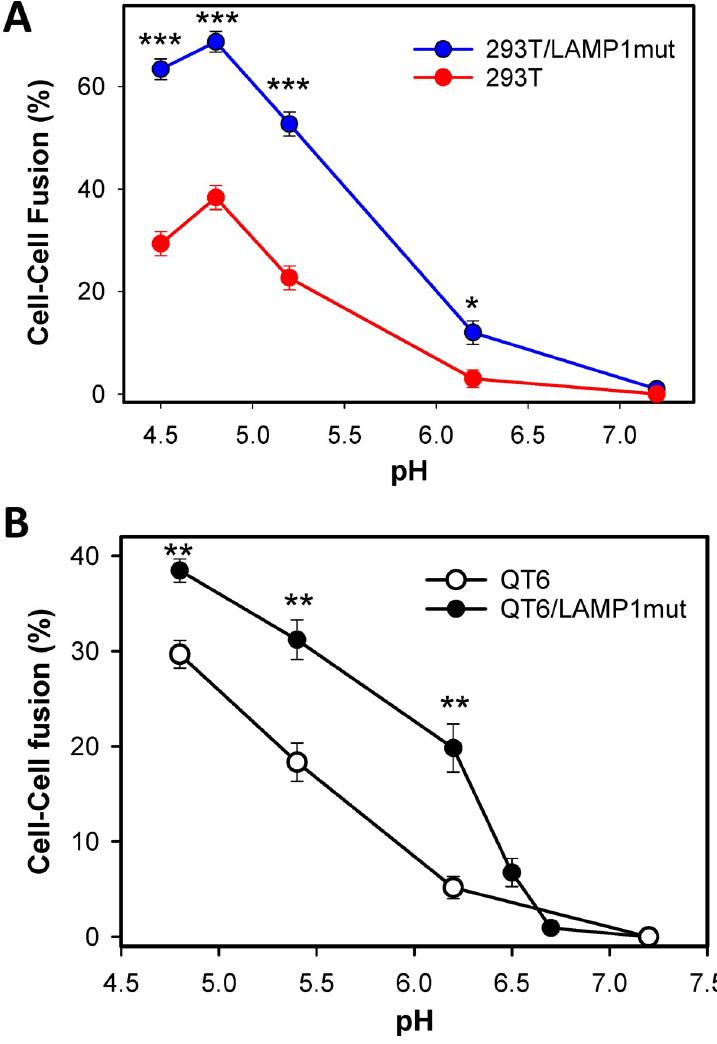
Fig 3. pH-dependence of LASV GPC-mediated cell-cell fusion. (A) Fusion between COS7 cells transfected with LASV GPC and HEK293T cells mock-transfected or transfected with LAMP1mut was triggered by exposure to buffers of different acidity for 20 min at 37˚C (optimal trigger). The results are means and SEM from three independent experiments. (B) pH-dependence of fusion, using the protocol described in panel A, was measured between LASV GPC-expressing COS7 cells and plain QT6 cells or QT6 cells transfected with LAMP1mut. The results are means and SEM from three independent experiments. � , p < 0.05; �� , p < 0.01, ��� , p < 0.001.